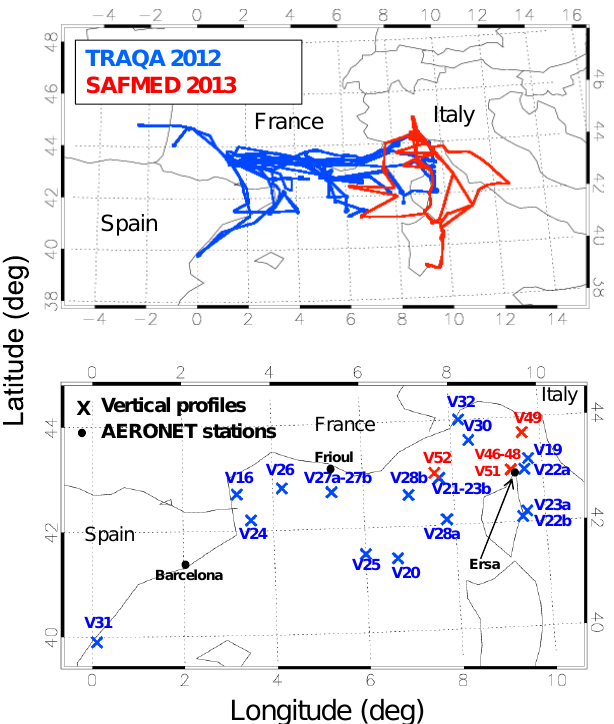
Figure 1. Upper panel: flight trajectories of the TRAQA (20 June– 13 July 2012) and the SAFMED (24 July–1 August 2013) cam- paigns. The aircraft was based in Toulouse, France (43 ◦ 36 (cid:48) N, 1 ◦ 26 (cid:48) E), during TRAQA and in Genoa, Italy (44 ◦ 24 (cid:48) N, 8 ◦ 55 (cid:48) E), during SAFMED. Lower panel: detail on the investigated area and geographical position of the different vertical soundings analysed in this paper. The position of the three AERONET stations of Barcelona, Frioul, and Ersa considered in this study is also